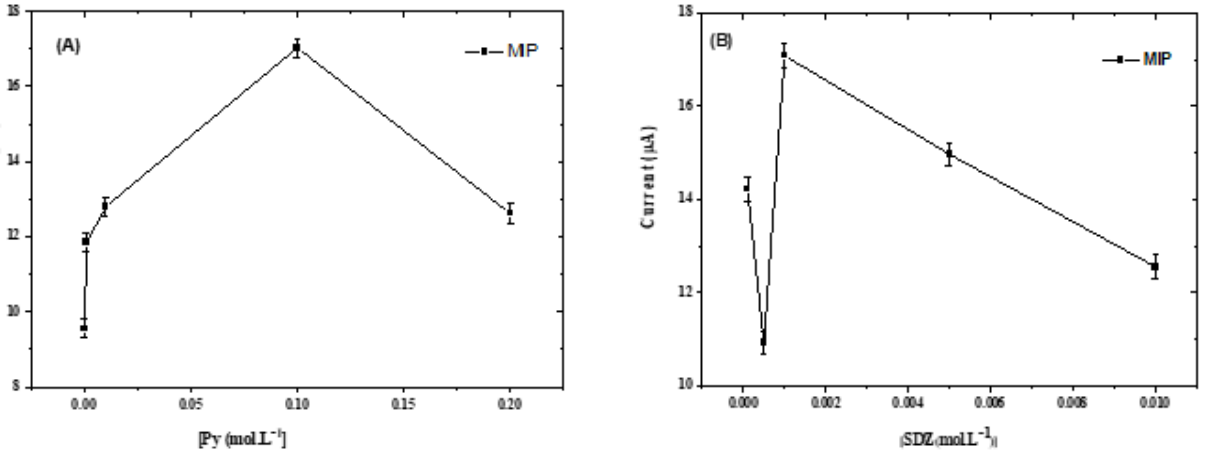
Figure 7. Effect of pyrrole ( A ) and sulfadiazine ( B ) concentrations on the DPV peak current of sulfadiazine. Measuring conditions: 10 − 6 mol L − 1 SDZ in 0.1 mol L − 1 H 2 SO 4 (pH = 2).